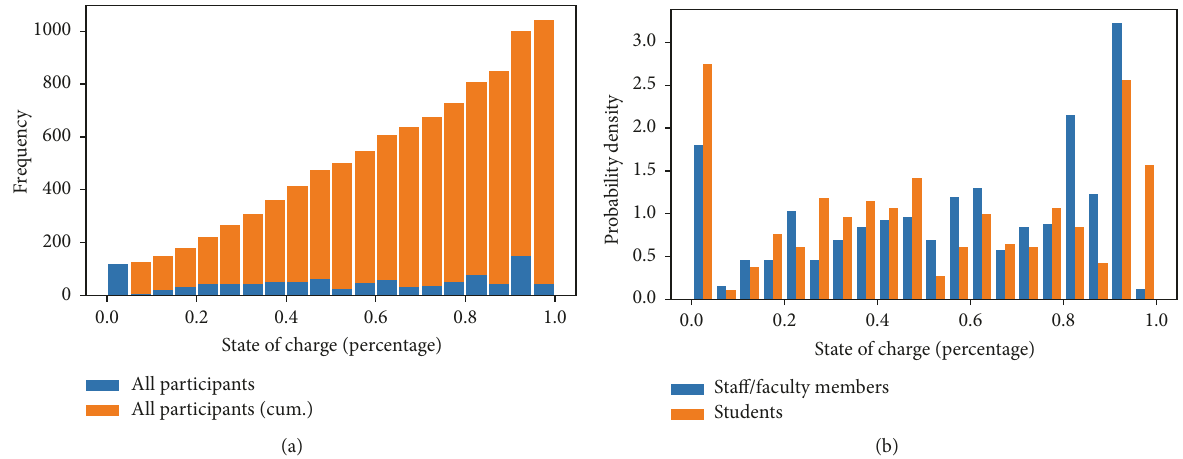
Figure 6: (a) Start of a charge cycle (cumulative) frequency over state of charge; (b) probability distribution of the start of a charge cycle over state of charge, split by